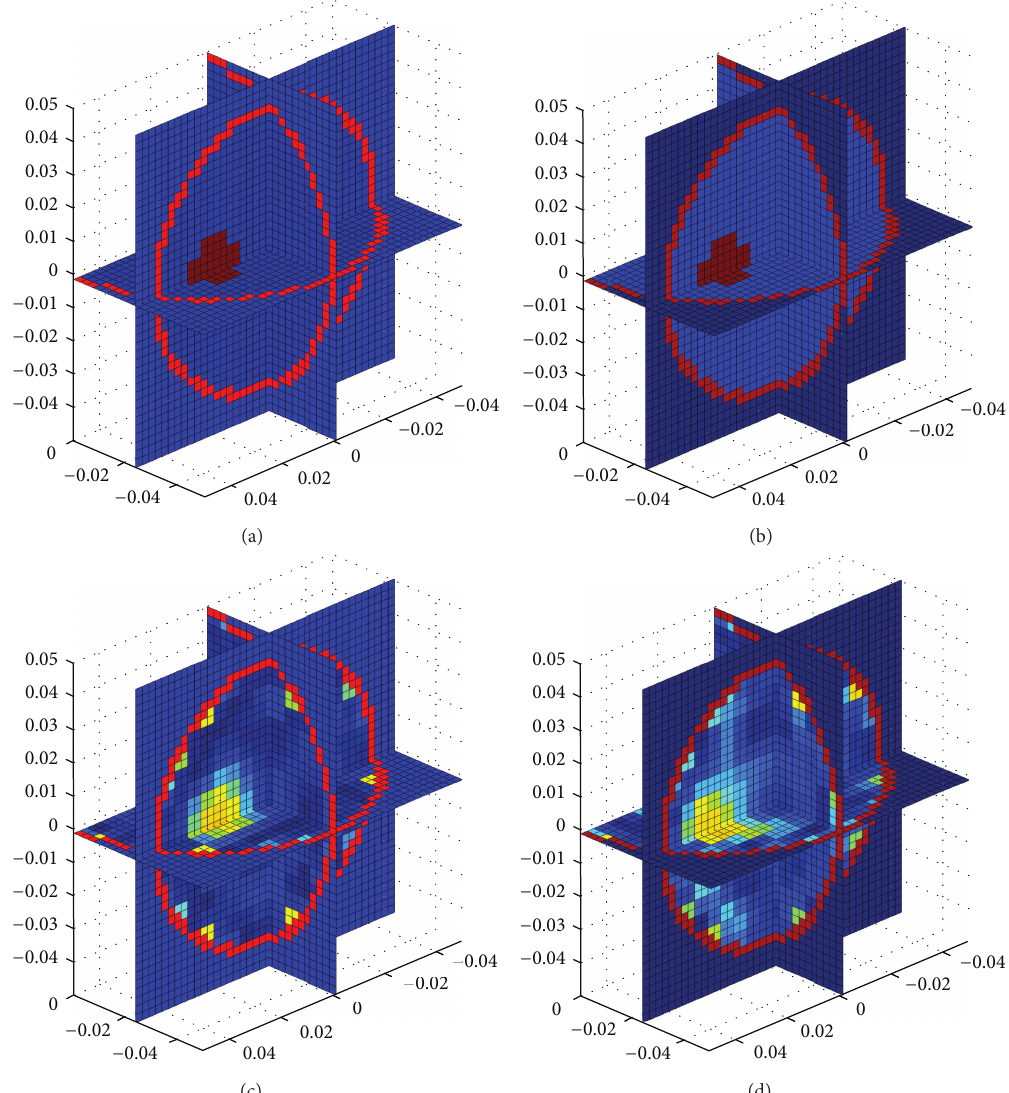
Figure 12: Exact permittivity (top) and partially reconstructed permittivity inside the skin layer (bottom) for the numerical simple breast phantom with a 2 cm diameter tumor and with skin. Real part (left) and − imaginary part (right). The SNR of the data is 30 dB. Distances are in m.